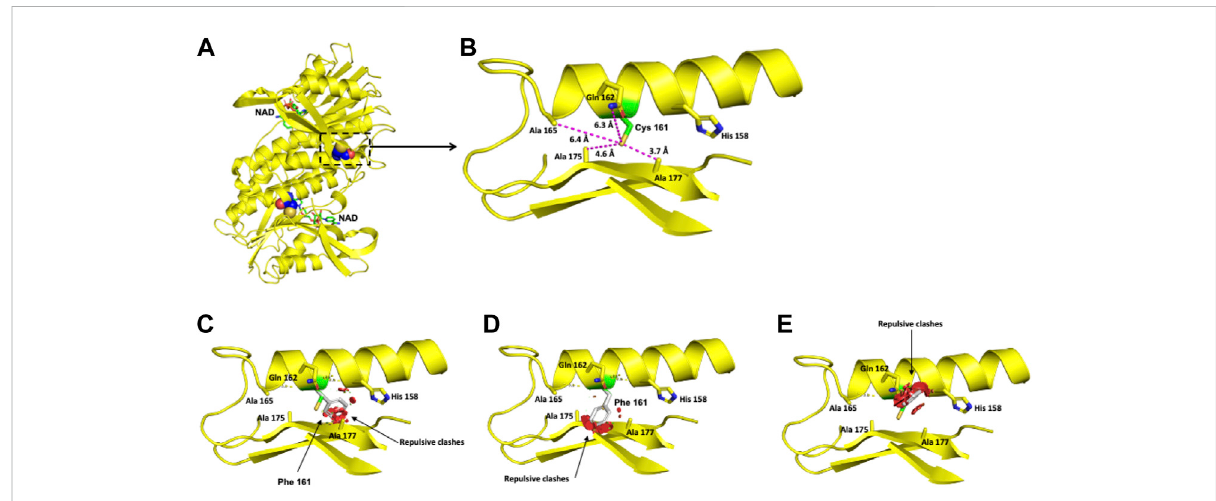
FIGURE 5 Modeling of the human DHPR structure with p.(Cys161Phe) change. (A) Crystallographic structure of a dimer of DHPR and location of the Cys 161 residues on each monomer. (B) Location of the Cys 161 residue in one monomer. (C – E) Potential pathogenic effects for the substitution of Cys by